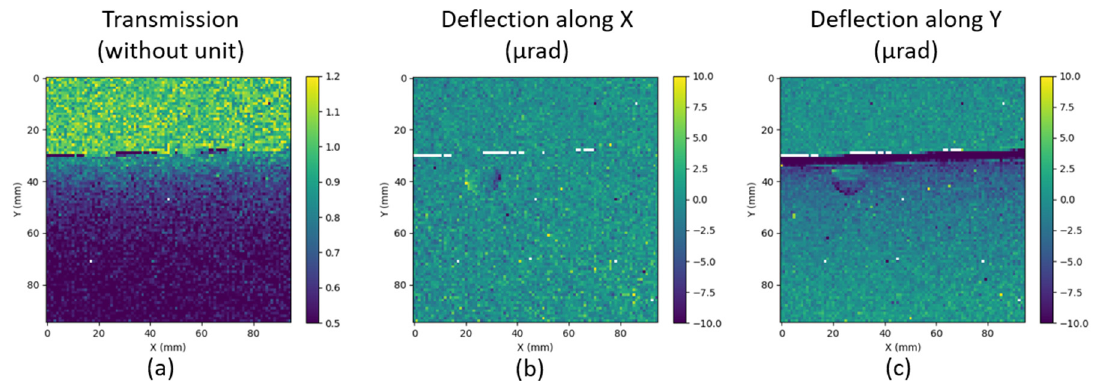
Figure 18. ( a ) Transmission map, ( b ) deflection map along the X direction and ( c ) deflection map along the Y direction obtained with the sample (polycarbonate tube filled with water) located at ~6 cm from the mask.